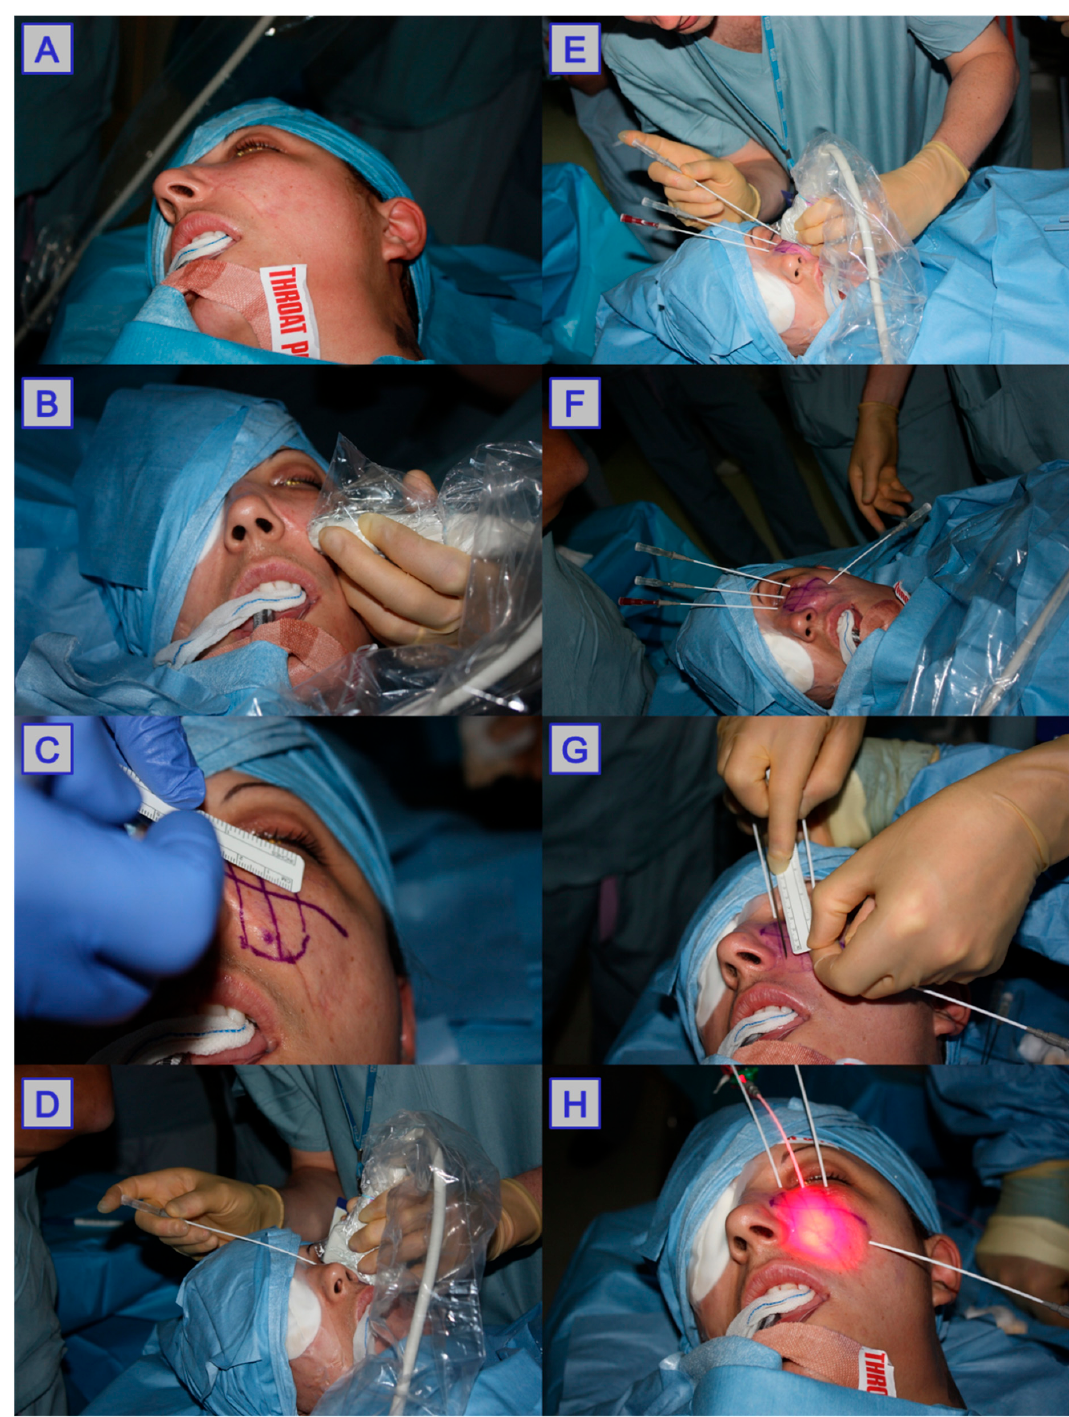
Figure 3. The steps involved in the interstitial PDT application to treat a left infraorbital haemangioma. ( A ): The patient is prepared with a drape and eye shield. ( B ): US is used to accurately identify the location of the lesion. ( C ): The locations for needle insertion are mapped out superficially. ( D ): US is used during the insertion of the first needle. ( E ): US is used for the insertion of subsequent needles. ( F ): The needles are inserted an appropriate distance from each other to ensure complete illumination of the tumour width and depth. ( G ): The needle tip in the tissue is measured to avoid damage in order to avoid necrosis of overlying healthy tissue. ( H ): The lesion is illuminated. Reprinted with permission from ref. [34]. Copyright 2011 Photodiagnosis Photodyn. Ther.